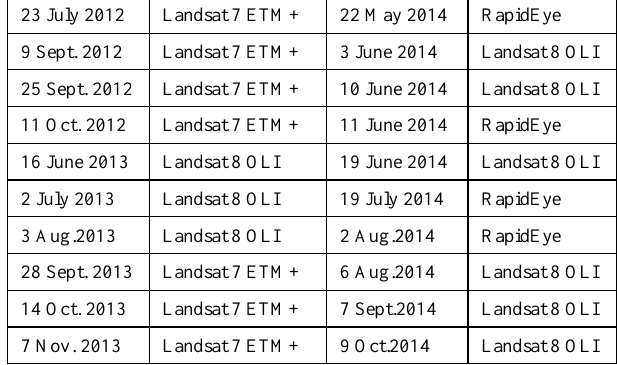
Table 1: Satellite data used for Plant Parameter Retrieval For validation of the yield estimation, in-situ data was provided by the farmer and the Südzucker AG. Field mean values were available for the years 2012 to 2014. This data is used to validate the yield estimation for several years on field level.